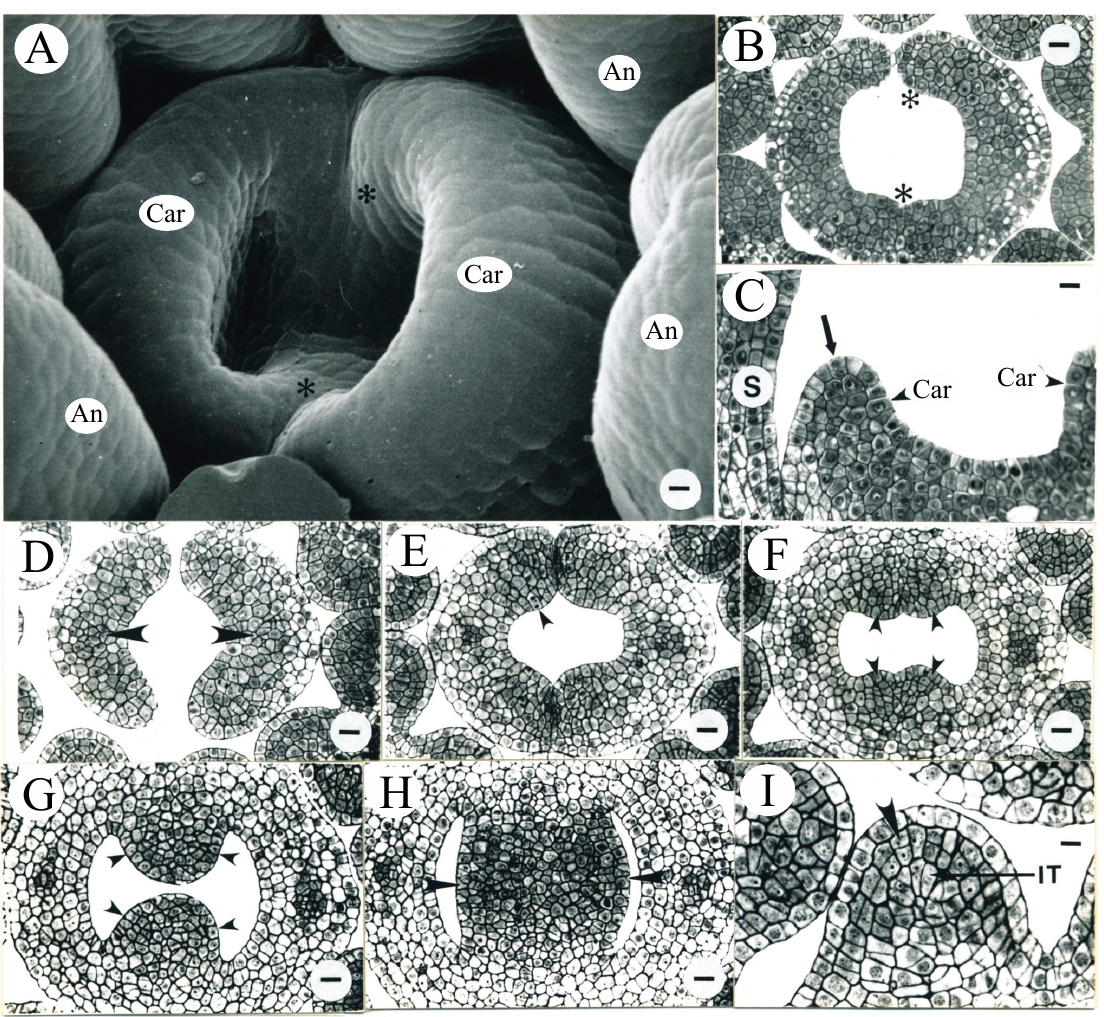
Figure 2. Tobacco pistil and anther development during the third day after ECP. ( A ) Representative SEM micrograph of a flower from the age interval 2.3 ± 1.2 days after ECP, showing two carpel primordia (Car) longitudinally elongating and arching inward. Asterisks identify the approximate location of the transverse section shown in ( B ). An, anther. Bar = 7.1 µ m. ( B ) Transverse section of the carpel primordia seen in ( A ). Asterisks identify the approximate location of the section seen in ( A ). Bar = 19.4 µ m. ( C ) Longitudinal section of the carpel primordia similar to those seen in ( A ). A recent periclinal division in L1 (arrow) is evident at the tip of one of the two carpel primordia (Car). The other carpel primordium is partially shown. S, stamen. Bar = 19.4 µ m. ( D – H ) Serial transverse sections from a single pistil similar to that seen in ( A ). ( D ) Evident procambium in the top portion of carpels (arrowheads). Bar = 12.5 µ m. ( E ) A recent cell division observed in L1 (arrowhead) in the margin of a carpel where two carpels have not fused. Bar = 23.1 µ m. ( F ) Densely stained cells in the inner carpel wall below the fused margins of the carpels (arrowheads). Bar = 23.1 µ m. ( G ) Densely stained cells in the central floral tissue enclosed inside the carpels (arrowheads). Bar = 20.5 µ m. ( H ) The primordial placentae (arrowheads) initiating inside the carpels. Bar = 20.5 µ m. ( I ) Transverse anther section showing a representative adaxial microsporangium from the age interval 3.0 ± 0.2 days after ECP. The majority of cells in L2 have completed a recent periclinal division (arrowhead) and the inner tapetum (IT) is now evident. Bar = 11.5 µ